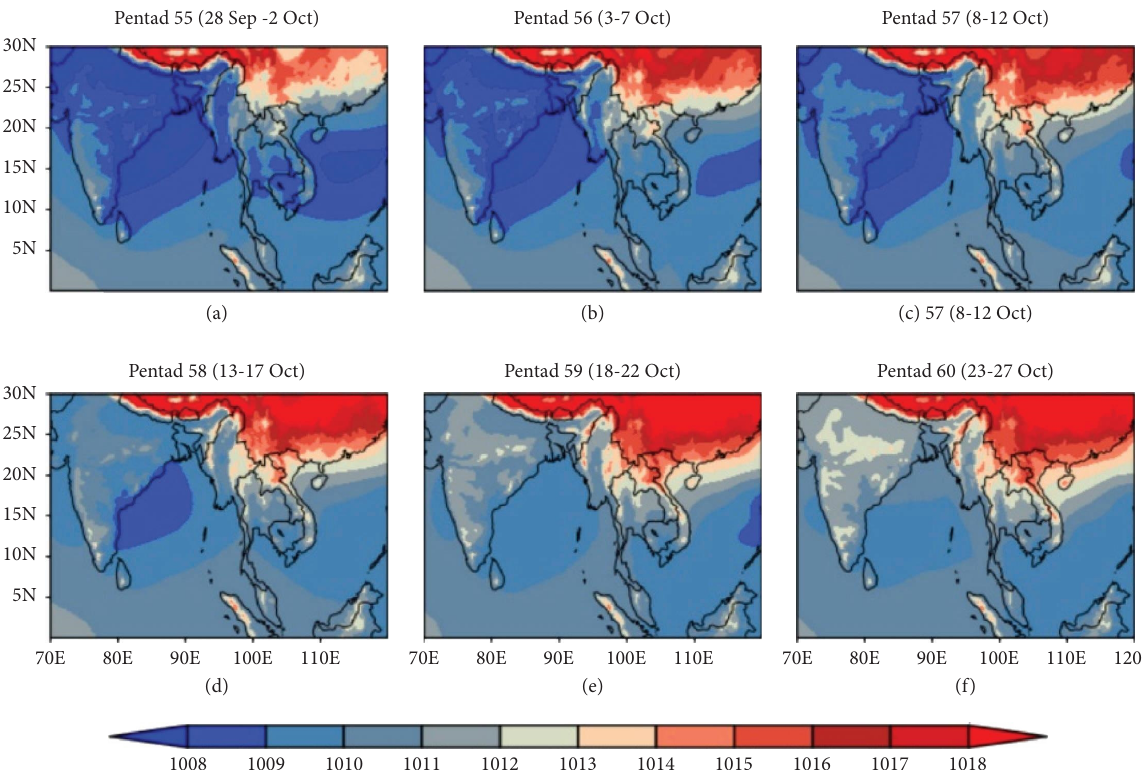
Figure 18: Composite of climatology (1991–2020) MSLP (hPa, colour) during the pentads: (a) P -55 (Sep 28–Oct 2), (b) P -56 (Oct 3–7), (c) P -57 (Oct 8–12), (d) P -58 (Oct 13–17), (e) P -59 (Oct 18–22), and (f) P -60 (Oct 23–27) during the monsoon withdrawal period.